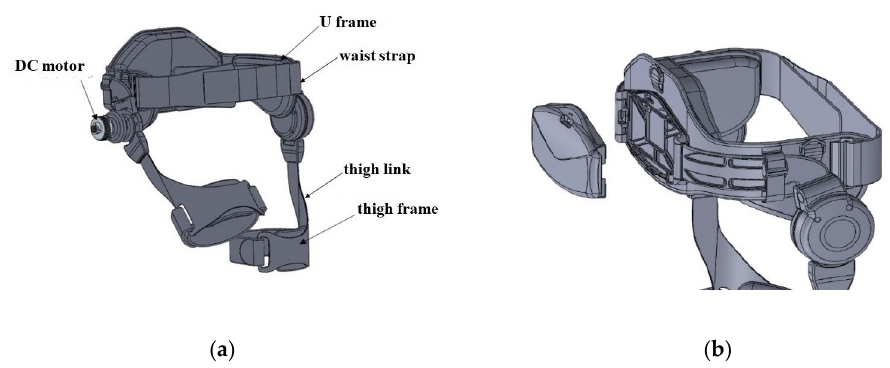
Figure 1. ( a ) Proposed robotic hip exoskeleton design, and ( b ) back pack for integration of electric devices.